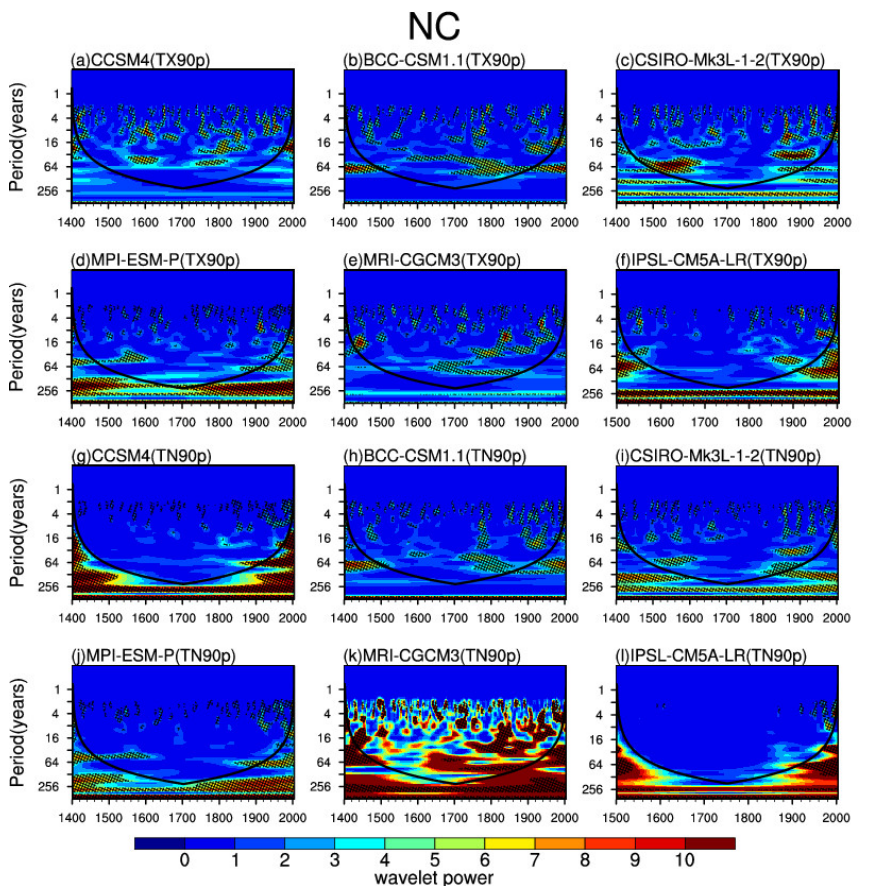
Figure 5. Wavelet analyses of TX90p and TN90p in NC from 1400–2005 CE. ( a – f ) Simulated TX90p by six models. ( g – l ) Simulated TN90p by six models. The shaded area shows the periods with confidence levels higher than 95% and the cone of influence is shown as the black line.